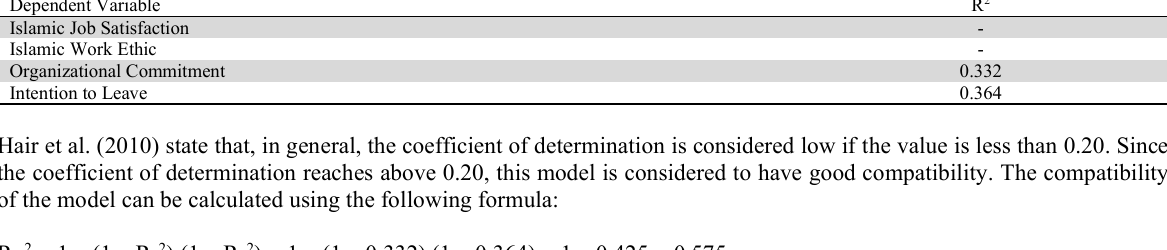
The Result of R-Square Measurement Dependent